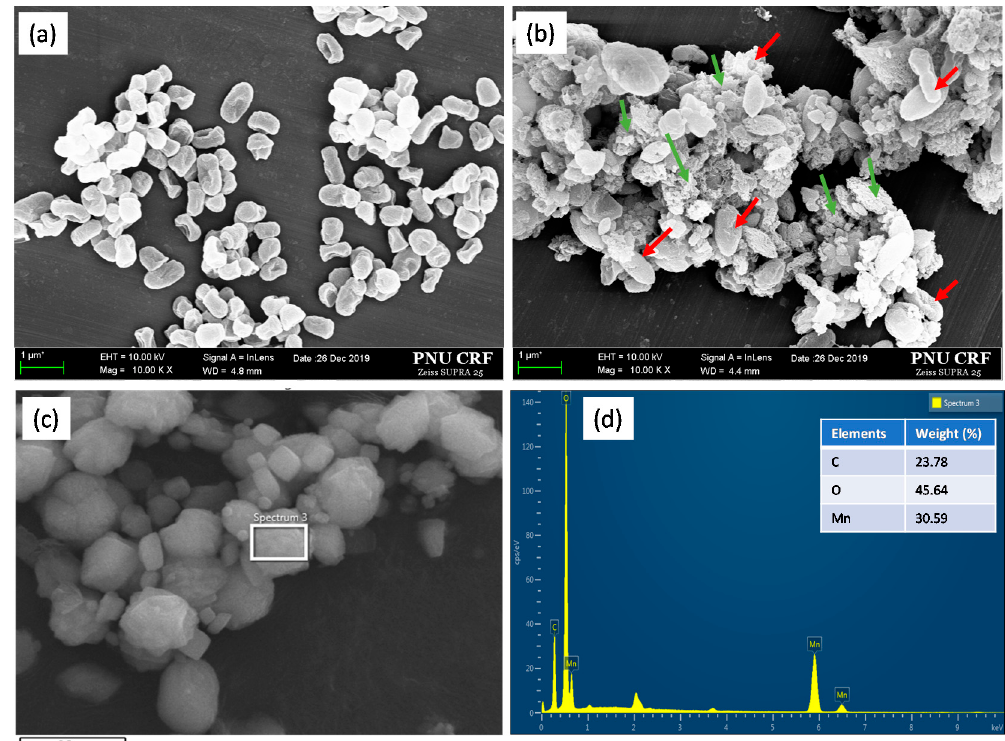
Figure 4. Electron microscopic analyses: SEM images of strains NDMn-6 growth ( a ) without Mn and ( b ) with Mn, at a magnification of 10,000 × ; ( c ) SEM image of Mn precipitates harvested from strain NDMn-6 culture, and ( d ) EDS spectrum of Mn precipitates. Red arrows indicate bacterial cells, and green arrows indicate Mn bioprecipitates.